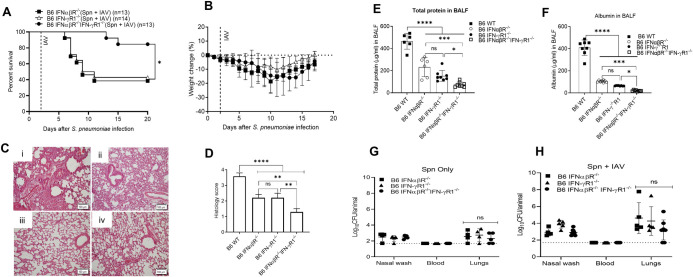
Susceptibility of mice deficient in type-I and/or type-II IFN pathways to pneumococcal-influenza virus superinfection.(A,B), C57BL/6 IFNαβR-/- (n = 13), IFN-γR1-/- (n = 14) and IFNαβR-/-IFN-γR1-/- (n = 13) mice were monitored for (A) survival and (B) weight loss following intranasal infection with 103 Spn on Day 0 and 50 PFU of IAV on Day 2. Survival data were analyzed by log-rank Mantel-Cox test. (C) Histopathology on Day 7 of co-infection. (Ci) wild type, (Cii) IFN-γR1-/-, (Ciii) IFNαβR-/- and (Civ) IFNαβR-/- IFN-γR1-/- mice. 20X magnification; scale = 100μm. (D) Histology scores for same groups shown in (C). The lesions were scored for levels of inflammatory infiltrates, edema, hyperemia and congestion, alveolar degeneration, necrosis of alveolar epithelium, necrotizing bronchitis and bronchiolitis. The scoring criteria were 0 for no change, 1 for mild change, 2 for moderate changes, 3 for marked changes and 4 for severe changes. 10 random fields per mouse were evaluated. Shown are mean ± SD for 3–5 mice/group. BALF were analyzed for biomarkers of tissue integrity (E) total protein, and (F) albumin. Each symbol represents an individual mice showing mean ± SD from 6 to 8 mice/group. (G,H) Bacterial loads in nasal washes, blood and lungs of (G) Spn only or (H) Spn-IAV co-infected C57BL/6 IFNαβR-/-, IFN-γR1-/- and IFNαβR-/-IFN-γR1-/- mice. Each symbol represents the CFU of an individual mouse with the solid lines showing mean ± SD from 4–8 mice. The dotted line indicates the limit of detection. Statistical analyses for (D-H) were performed by two-way ANOVA. *P<0.05; **P<0.01, ****P<0.0001; ns = not significant. The data in (A,B,G, and H) were pooled from two independent experiments.